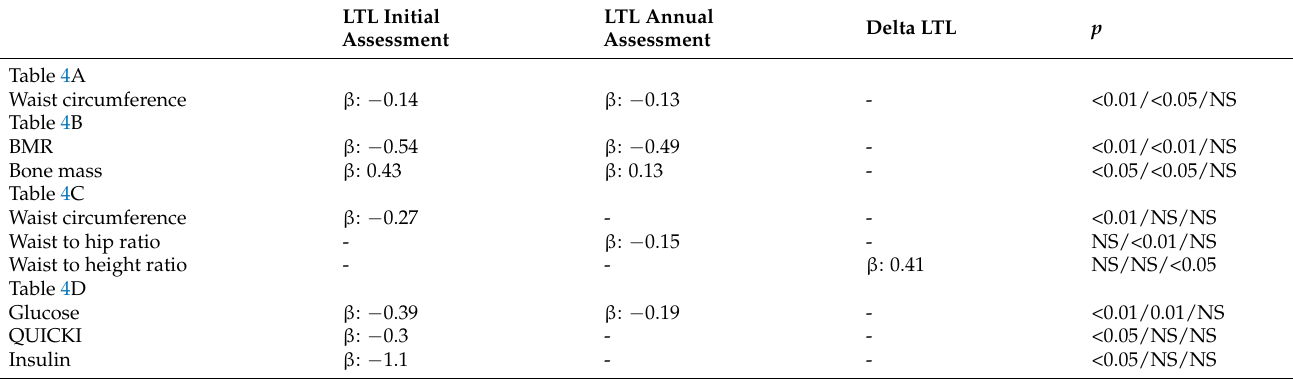
Table 4. Potential predictors in descending order of LTL at initial assessment, at annual assessment and the respective change (Delta) of LTL–dependent variables. Model A (Table 4A) assessed metabolic syndrome parameters, at initial assessment (SBP, waist circumference, cholesterol, triglycerides, and HDL; independent variables). Model B (Table 4B) assessed body composition parameters, at initial assessment (fat percentage, fat mass, muscle mass, bone mass, fat free mass, total body water and BMR; independent variables). Model C (Table 4C) assessed anthropometric parameters, at initial assessment (weight, height, BMI, waist, hip circumference, waist to hip ratio and waist to height ratio; independent variables). Model D (Table 4D) assessed glucose metabolism and insulin sensitivity parameters, at initial assessment (glucose, insulin, HbA1C, HOMA and QUICKI; independent